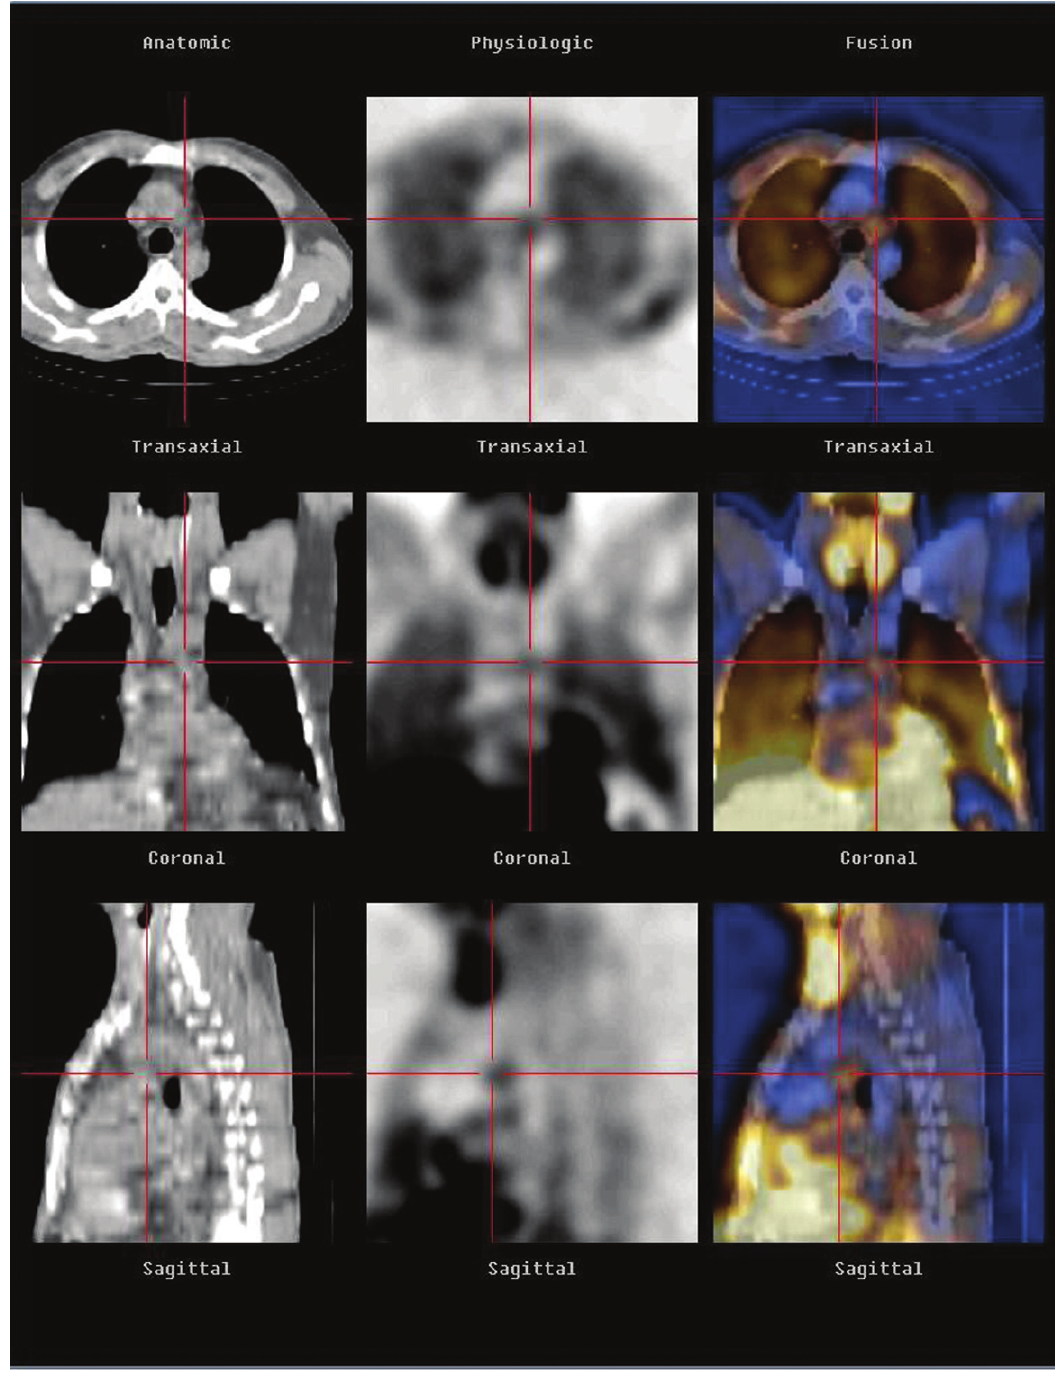
Figure 2 - SPECT/CT showing aorto-pulmonary window (station five) uptake in a patient with an adenocarcinoma of the